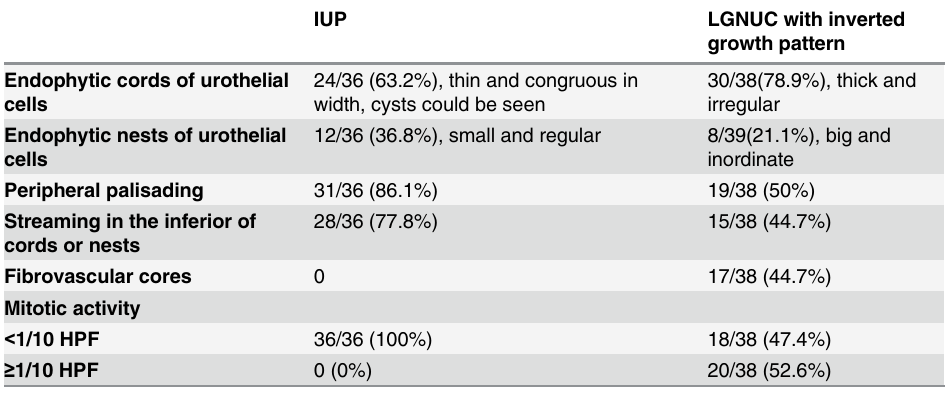
growth pattern 30/38(78.9%), thick and irregular inordinate